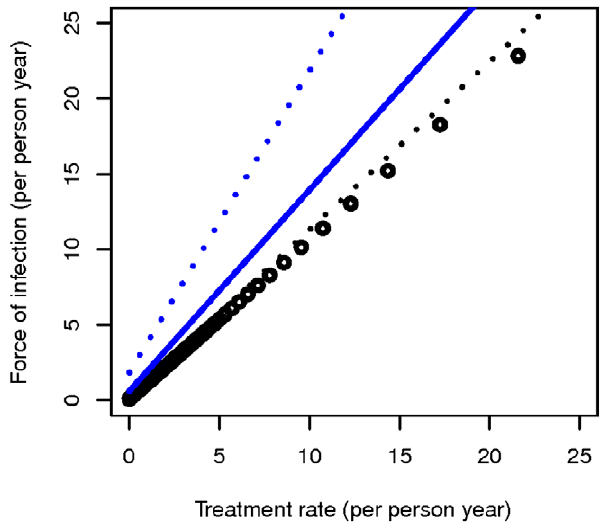
Figure 1. Force of infection against treatment rate. Force of infection ( l 0 : new infections per person year) against treatment rate (new infections treated per person year) at 5% measured prevalence (black lines) and 25% measured prevalence (blue lines), with perfect detectability (solid lines) and 50% detectability (dotted lines), with an average natural parasitaemia duration of 200 days.